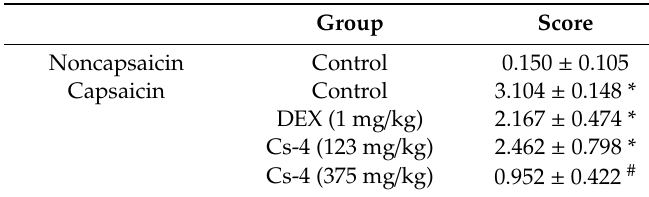
Table 2. The effects of Cs-4 on the cutaneous lesions of capsaicin-challenged rats. Table 2. The e ff ects of Cs-4 on the cutaneous lesions of capsaicin-challenged rats.